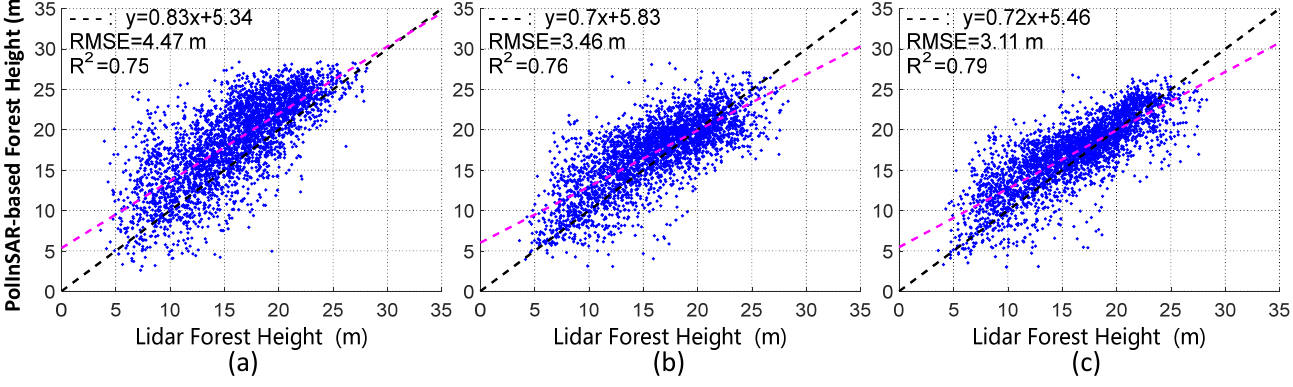
Figure 11. Statistical results of boreal forest height estimation. ( a ) Dual-baseline PolInSAR forest height inversion results based on the RVoG model; ( b ) dual-baseline PolInSAR forest height inversion results based on the PCT model; ( c ) dual-baseline PolInSAR forest height obtained by correcting the height of canopy scattering peak.